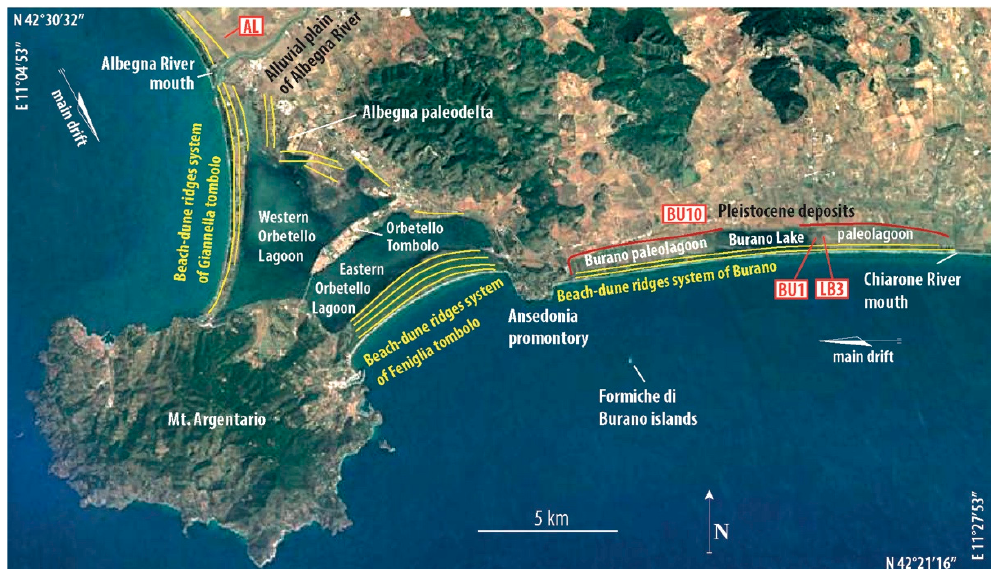
Figure 2. Morphological scheme of the Tuscany area. The yellow lines indicate the trend of the Holocene beach/dune ridges. The red line indicates the outline of the Burano paleolagoon. The labels in the white rectangles indicate the location of the boreholes, shown in Figure 3 (Image Landsat/Copernicus-Google Earth).